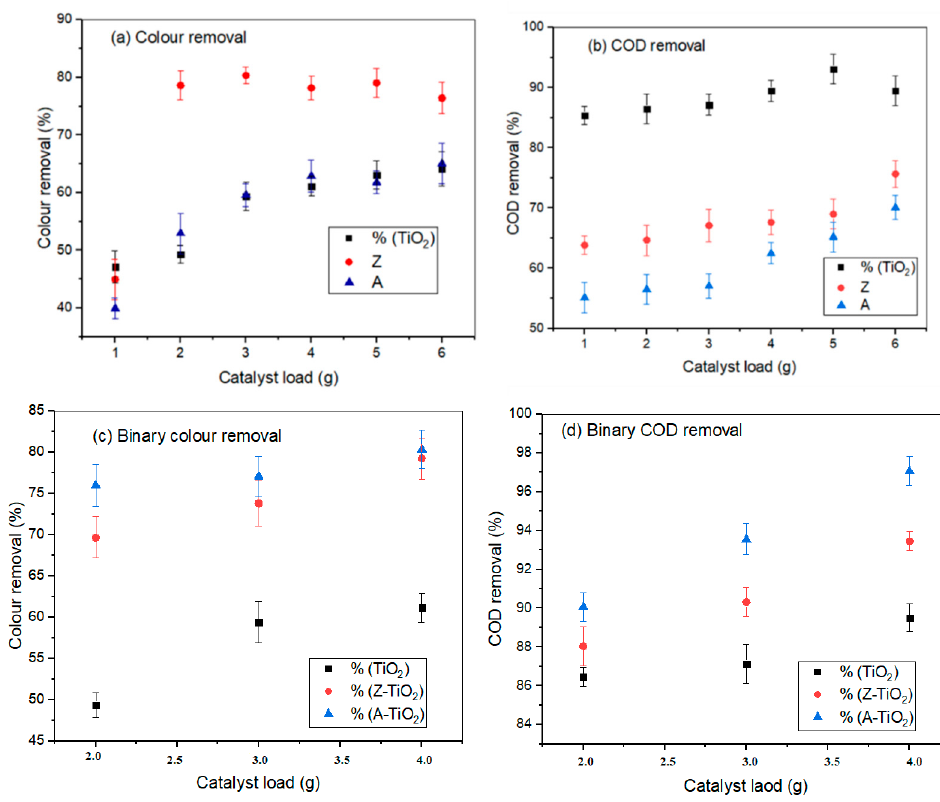
Figure 6. Effects of catalyst load at 1–6 g for the removal of ( a ) color (458 Pt. Co) and ( b ) COD (367.7 mg/L) with subsequent binary catalyst load effect of 2–4 g ( c , d ) at a reaction time of 30 min.